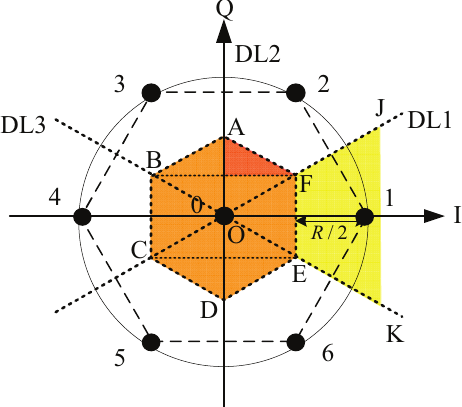
Figure 3. The decision regions of 7-QAM constellation